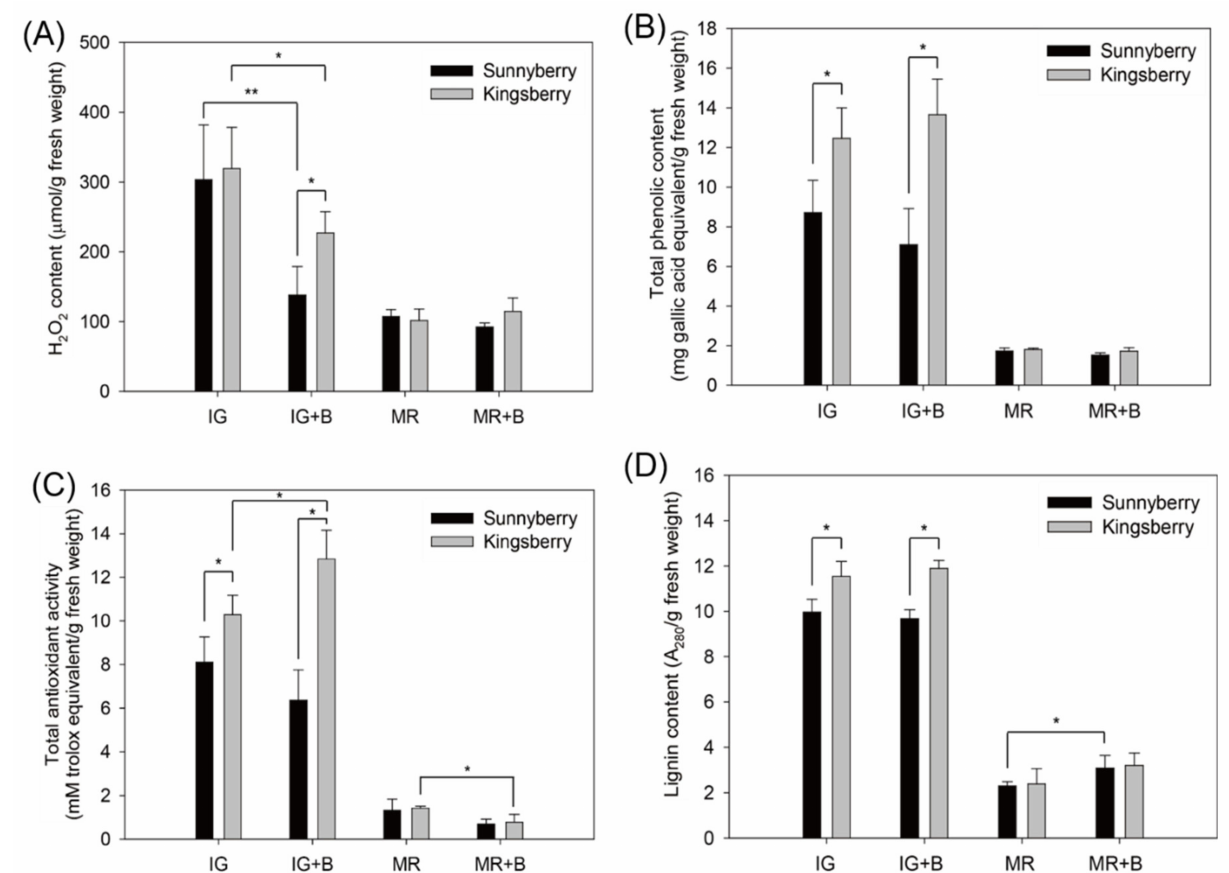
Figure 6. Changes in the physiological properties of “Sunnyberry” and “Kingsberry” strawberry. ( A ) H 2 O 2 content, ( B ) total phenolic content, ( C ) total antioxidant activity, and ( D ) lignin content. IG, immature-green fruit without inoculation; IG + B, immature-green fruit at 5 d after inoculation; MR, mature-red fruit without inoculation; MR + B, mature-red fruit at 10 d after inoculation. Data are means ± SD for four biological replicates. Asterisks indicate statistically significant differences between cultivars. *, p < 0.05; **, p <